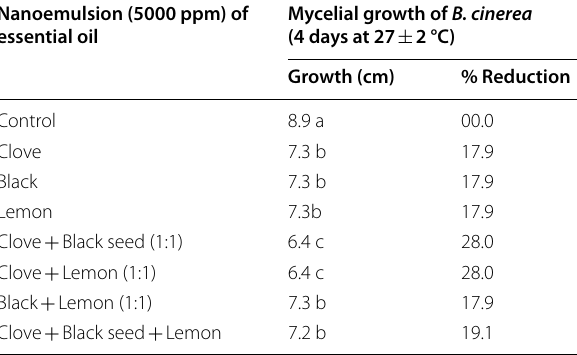
Table 2 Effect of nanoemulsion formulations of oil on mycelial growth of B.